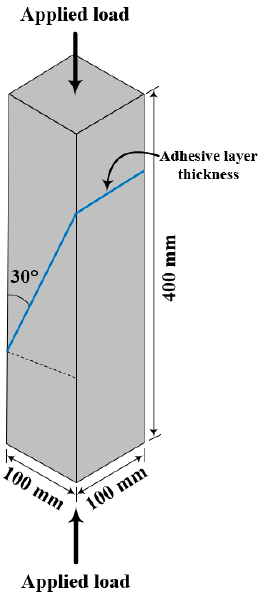
Figure 1. Specifications for the concrete specimen described in BS EN 12615 [20].